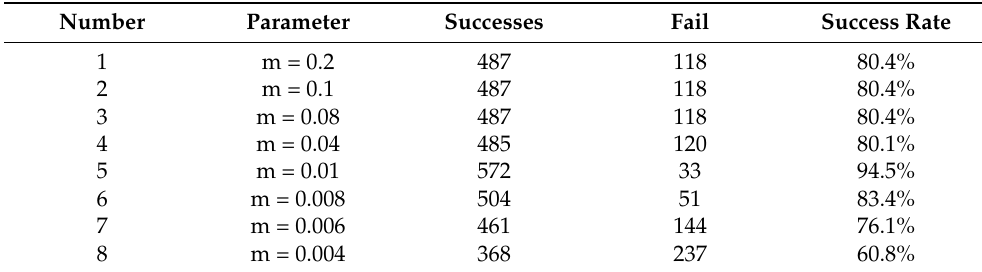
Table 2. Segmentation success rate under different parameters.